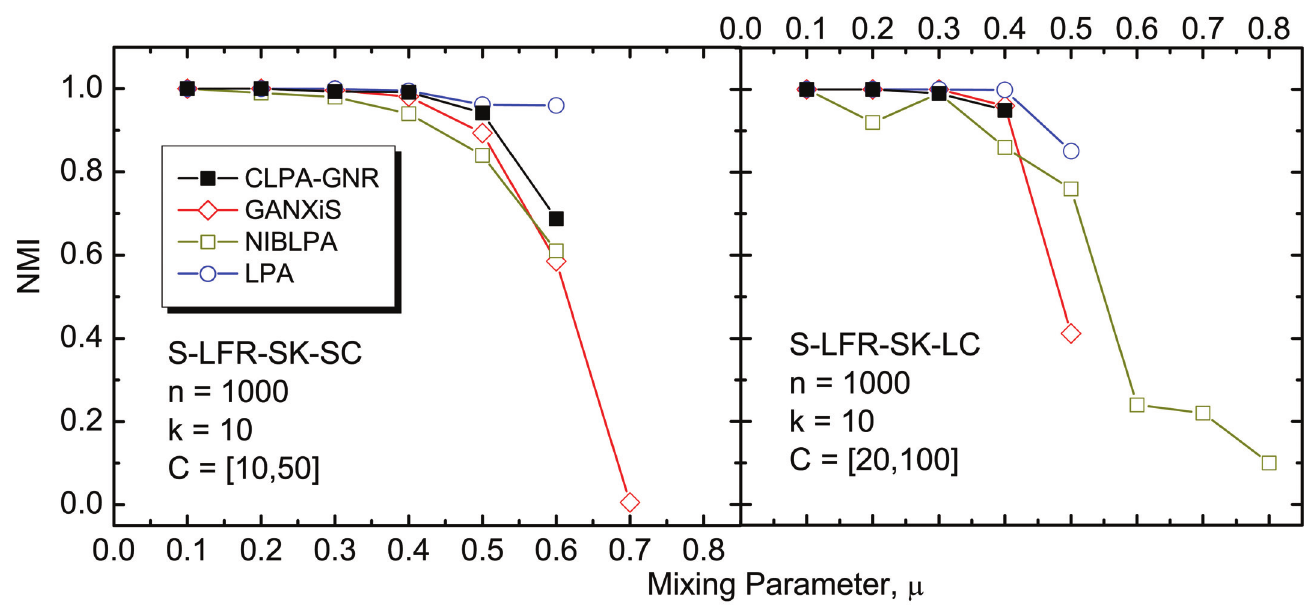
Fig 4. The NMI comparison on undirected and unweighted small LFR benchmark networks with small average degree. The size of the networks, size of the communities and the average degree are n , C and k , respectively.